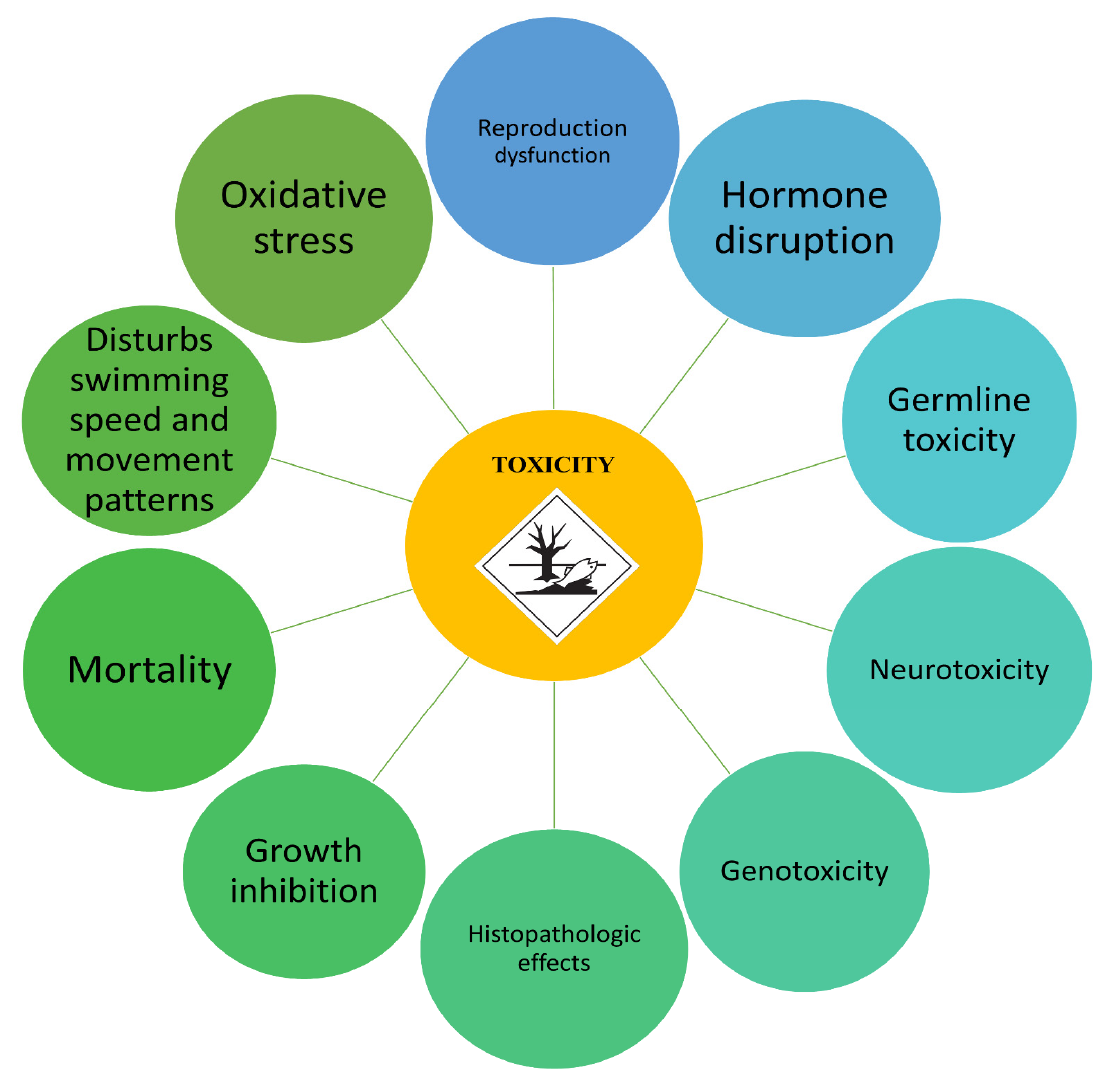
Figure 2. Toxicity of cosmetic preservatives.